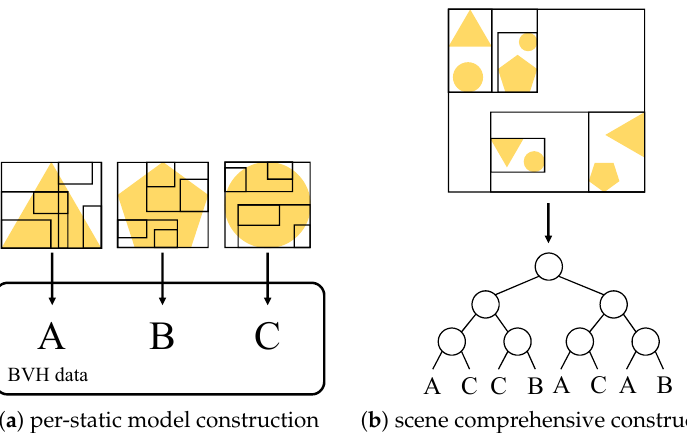
Figure 9. Two separate BVH tree constructions: the scene comprehensive construction uses the per-static models as the pre-processed and duplicated